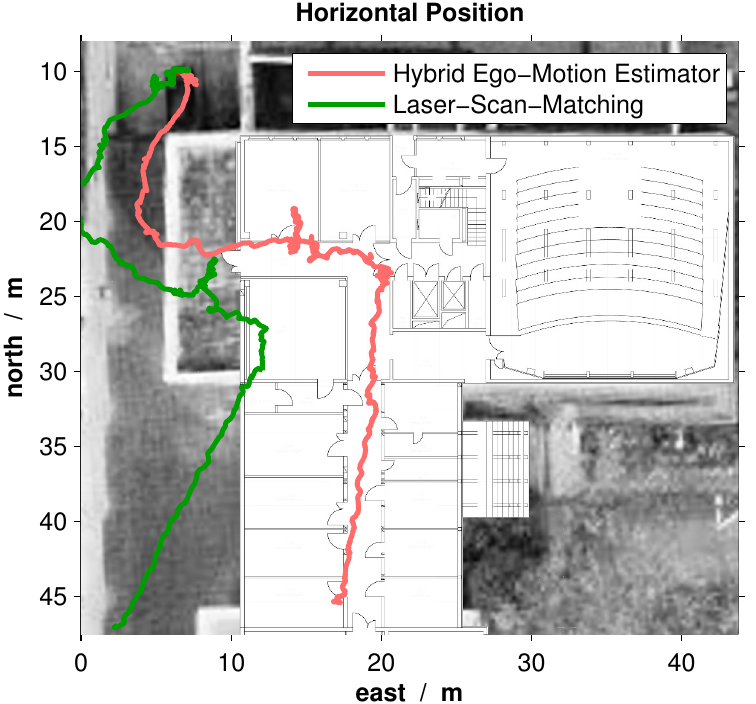
Figure 15. Reprocessed trajectories of the Laser-Scan-Matching (LSM)-aiding and hybrid sensor-aiding system, respectively. The real flight began outside of the building and ended at the end of the corridor. The starting point and the initial orientation of the MAV are measured. Moreover, the building plan with its constraints, e.g., doors and corridor, gives an idea of the ground truth trajectory. Aerial image: c (cid:13) Stadt